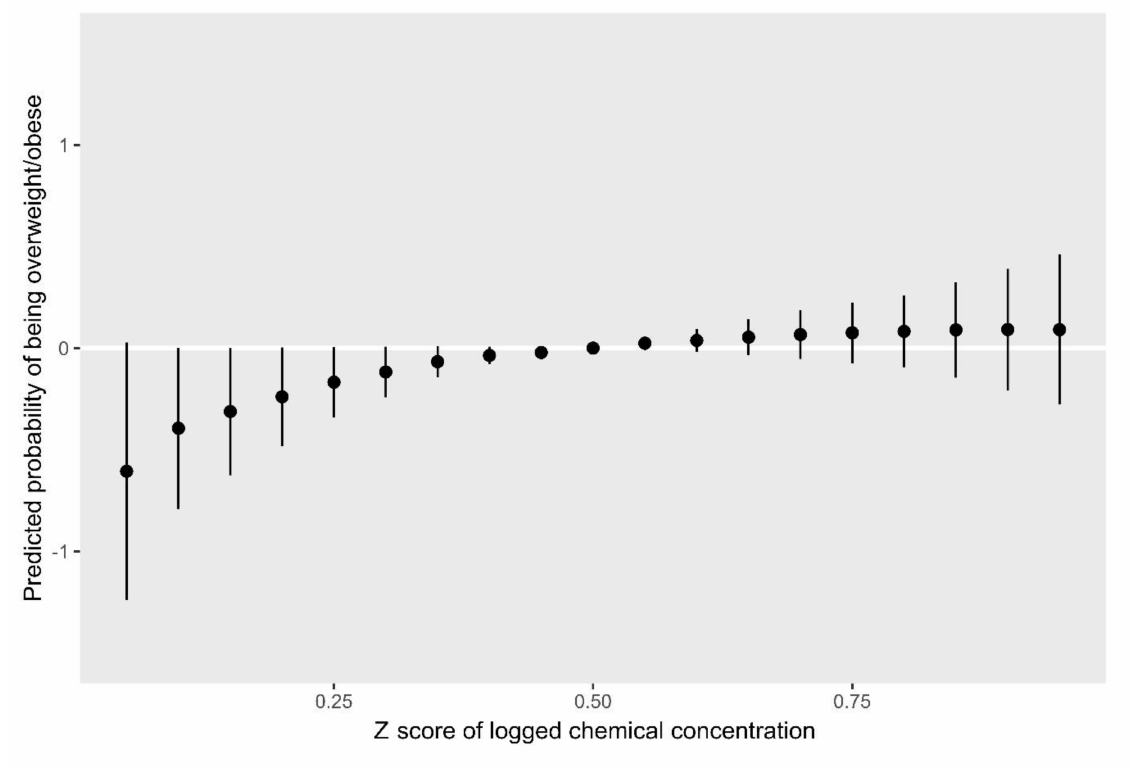
Figure 5. Predicted probability of being overweight/obese by quantiles of total log2 biomarker concentration z